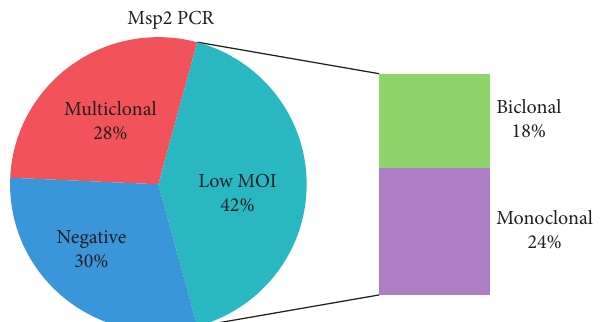
Figure 5: Multiplicity of Infection. A bar of pie chart illustrating the msp2 PCR results. The P. falciparum -positive samples were subjected to msp2 PCR to determine the multiplicity of infection (MOI). Samples that did not yield any PCR amplicon were clas- sified as negative. Those that yielded more than two amplicons were classified as multiclonal and those that yielded one (monoclonal) and two (biclonal) classified as containing infections with low MOI. The numbers in the figure are as a percent of the 140 P. falciparum - positive